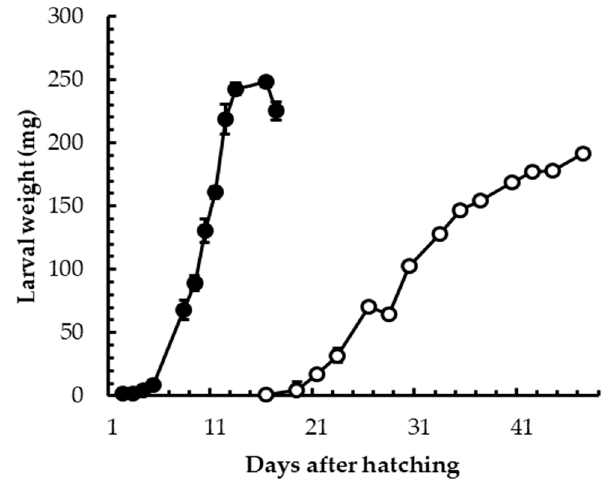
Figure 1. Development time of black soldier fly (BSF) larvae grown on SD (black circles) and VMD (white circles under laboratory conditions. Bars refer to standard deviation.